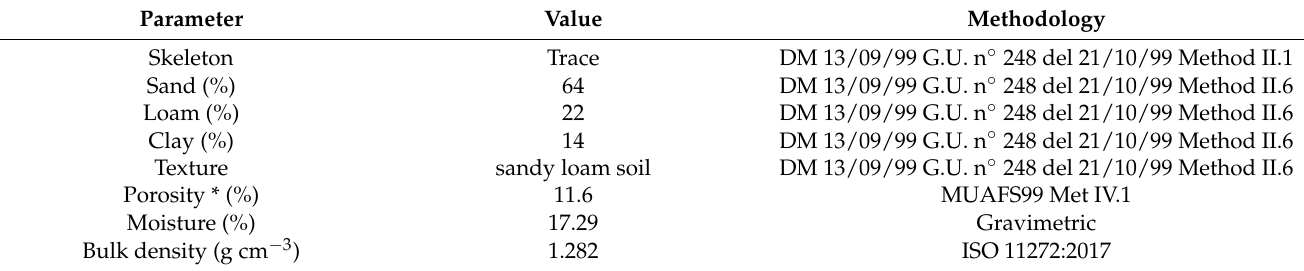
Table 3. Physical parameters of the soil.